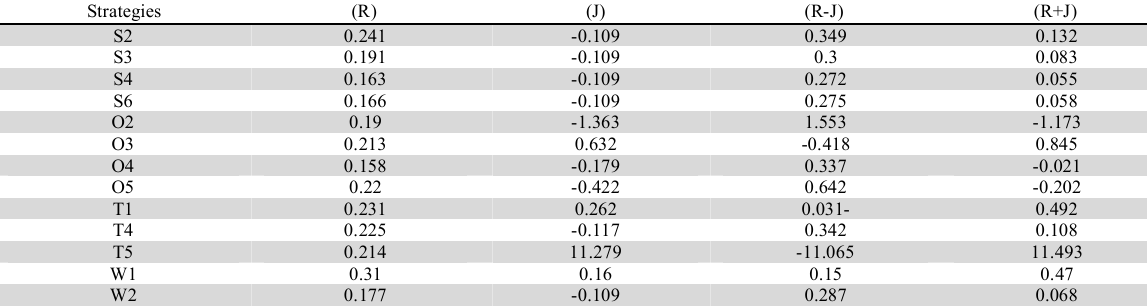
The summary of DEMATEL computations